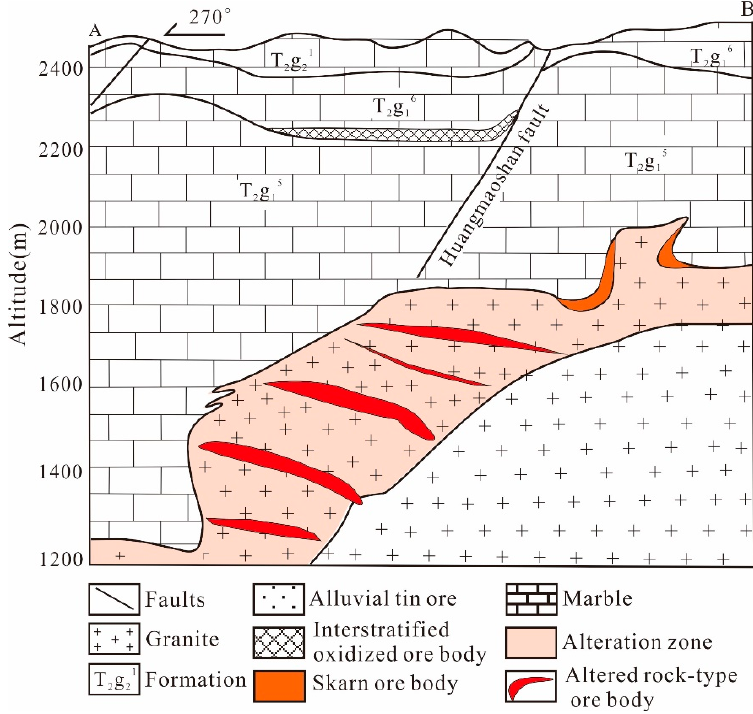
Figure 2. Mineral geological map of 164 exploration lines (after [29]). Table 2. The mineral assemblage characteristics of altered-rock type ores in Xi’ao deposit.